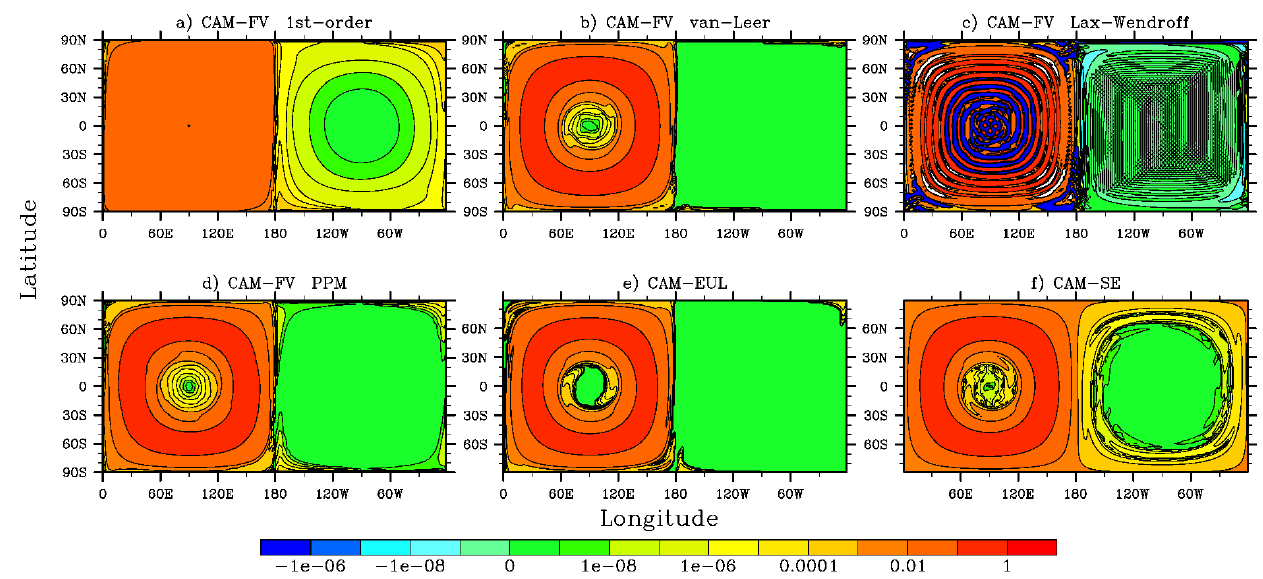
Fig. 11. Tracer mixing ratio results for Test 4. At time t = T , CAM-FV (a) 1st-order, (b) van Leer, (c) Lax–Wendroff, and (d) PPM with the default limiter, (e) CAM-EUL and (f) CAM-SE. The contours use a log scale.